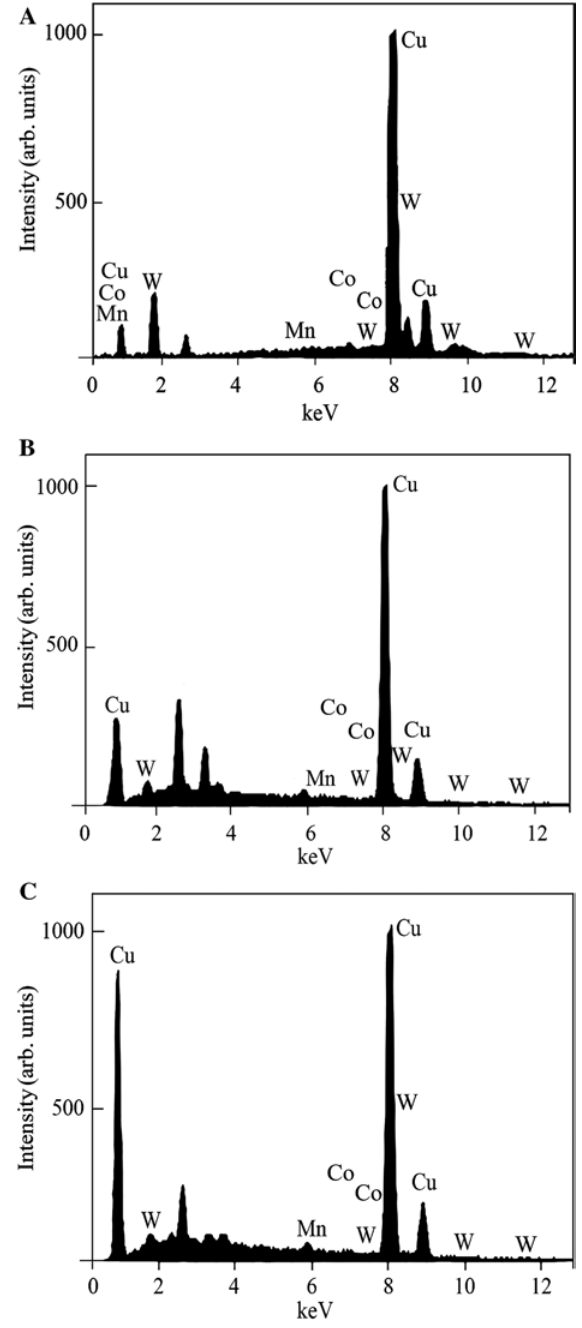
Figure 4: EDS results of different areas in the brazing seam